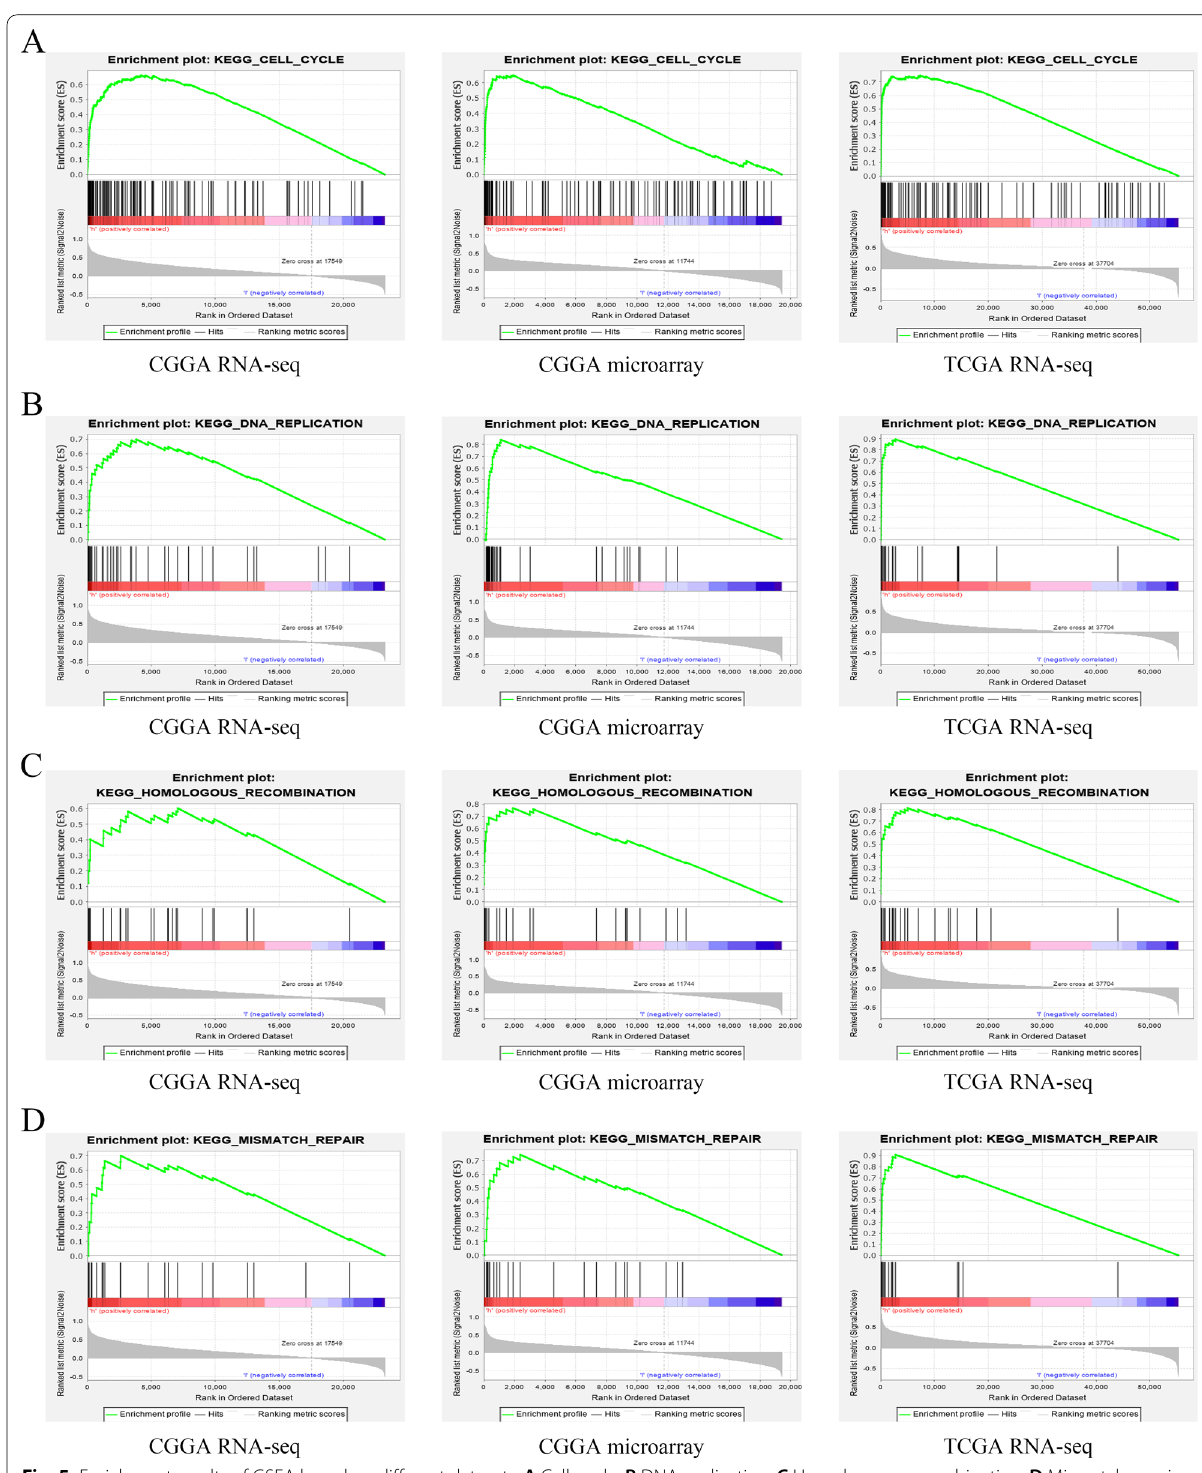
Fig. 5 Enrichment results of GSEA based on different datasets. A Cell-cycle, B DNA-replication; C Homologous-recombination; D Mismatch-repair. GSEA gene set enrichment